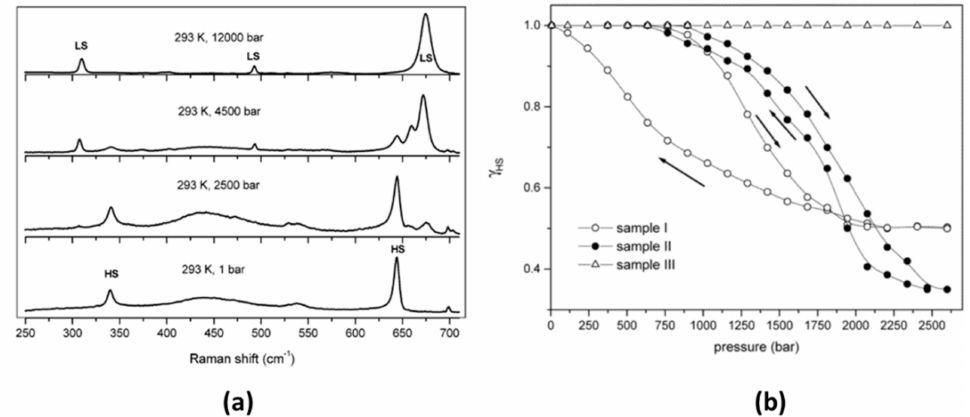
Figure 13. ( a ) Raman spectra of Fe(pz)[Pt(CN) 4 ] · 2H 2 O at different pressures. ( b ) HS fraction as a function of pressure as extracted from Raman analysis; arrows indicate the increase/decrease in pressure. The figure is reprinted with permission from ref. [42], copyright 2003, American Chemical